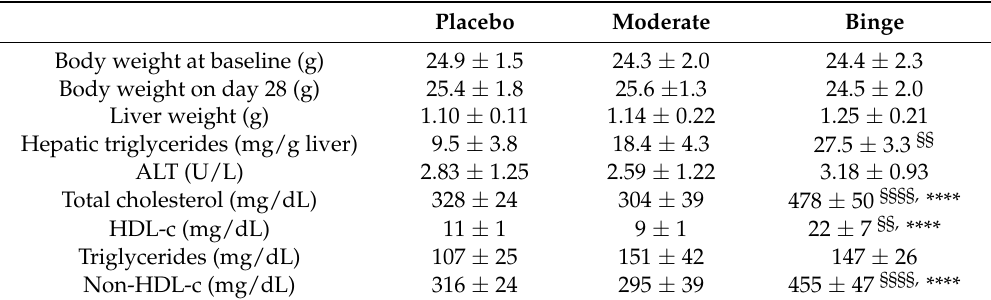
Table 1. Effect of moderate or binge alcohol consumption on body weight, liver function, and plasma lipid